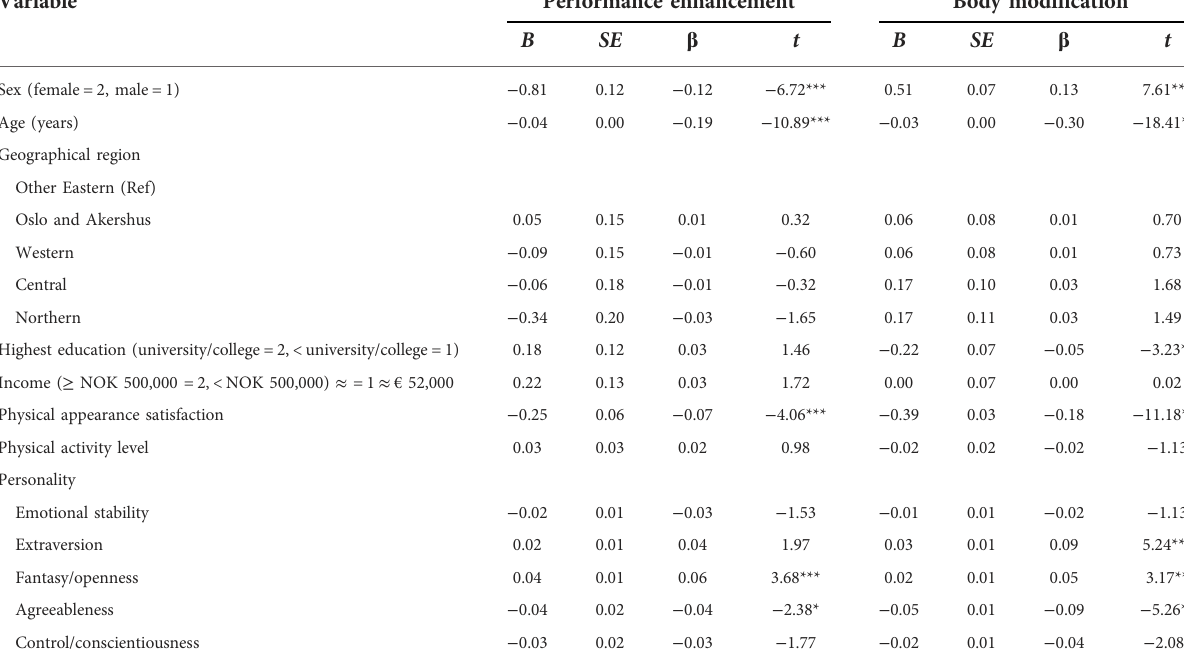
TABLE 4 Multiple regression analysis of predictors of willingness towards performance enhancement and body modi fi cation.